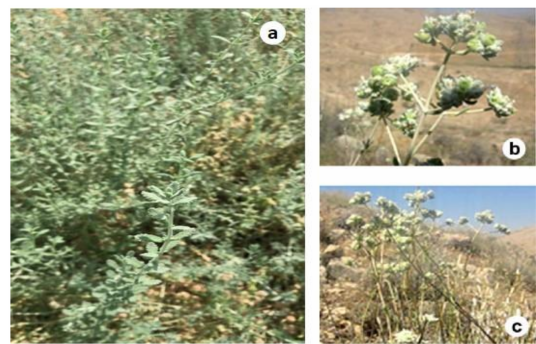
Figure 1. Vegetative growth ( a ), budding ( b ), and full bloom ( c ) of T. polium collected from Hail